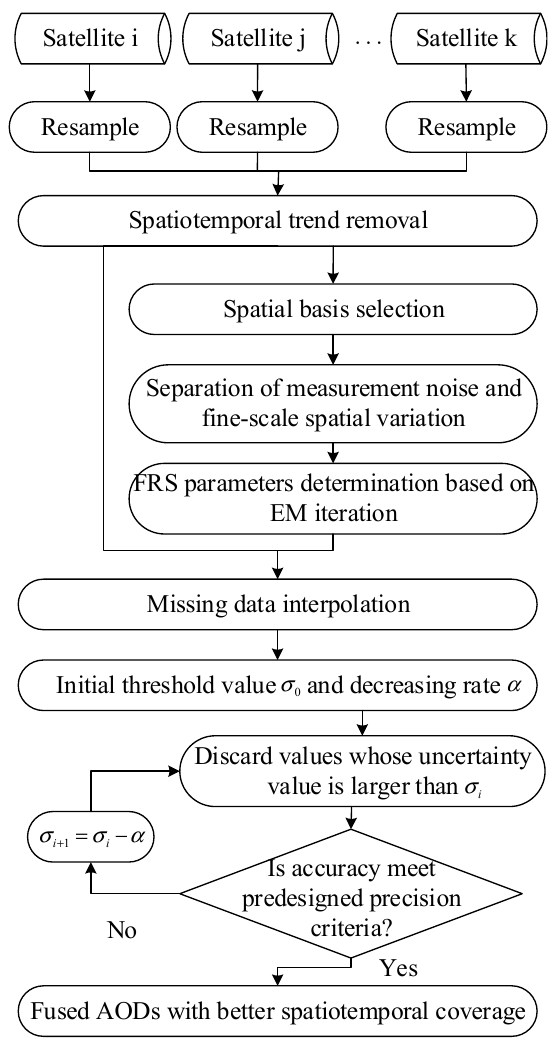
Figure 1. The flowchart of fusion process of aerosol optical depth (AOD) products from different satellite sensors based on the effective and efficient enhanced fixed rank smooth (FRS-EE) method.